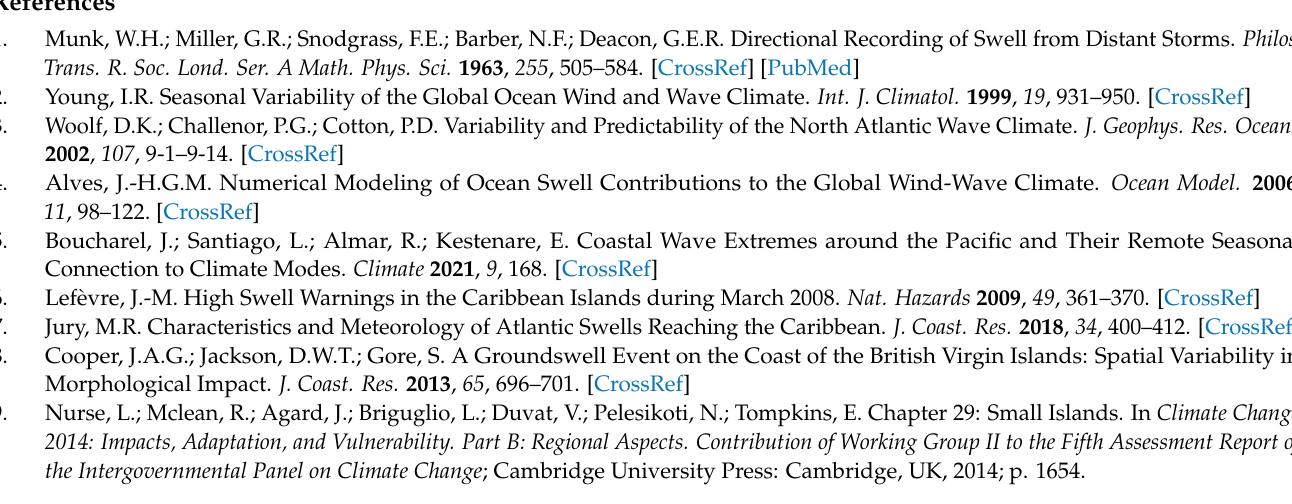
Figure S3: Composite averages for high pressure induced Md probability north swells; Figure S4: Composite averages for low probability north swell event; Table S1: North swell